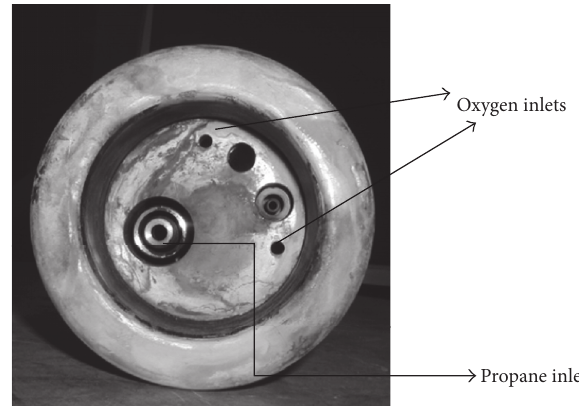
Figure 4: A photo of the burner configuration including the oxygen and propane inlets.